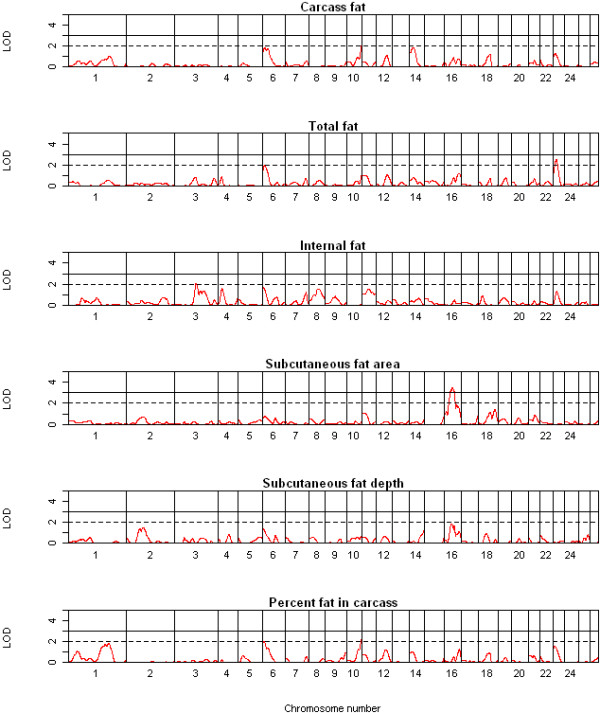
QTL map of the entire genome for carcass fat, total fat, internal fat, subcutaneous fat depth, subcutaneous fat area and percentage fat.